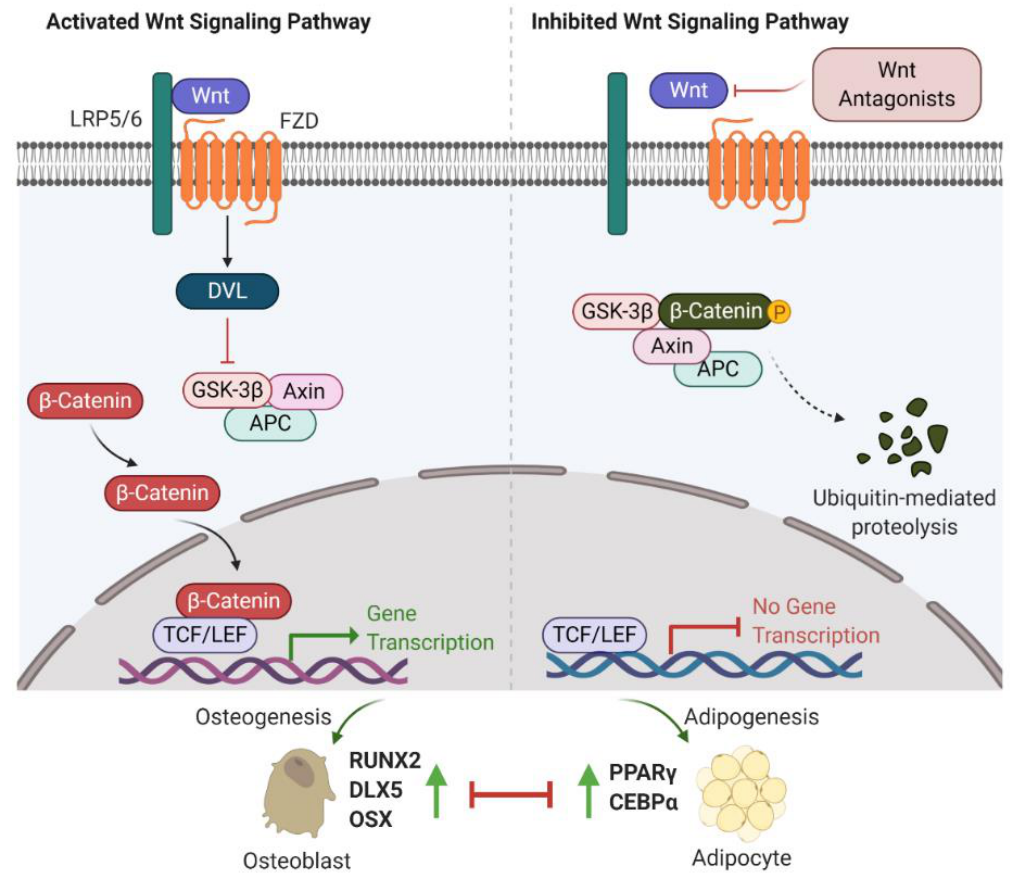
Figure 1. Wnt/ β -catenin signalling involved in bone or fat regulation. ( Left ) In case Wnt ligand is binding to co-receptor complex, β -catenin is released from the destruction complex composed of GSK-3 β , Axin and APC. This allows β -catenin to be accumulated and translocated into nucleus. By interacting with TCF/LEF transcription factors, β -catenin activates the osteogenic-related gene transcription program and promotes osteogenesis and bone formation. ( Right ) In case Wnt ligand is not able to bind to its co-receptor complex (e.g., in the presence of Wnt antagonists (sFRP-1, WIF-1, DKKs and sclerostin)), β -catenin is sequestered by the degradation complex, phosphorylated and subsequently degraded. Attenuated β -catenin enhances adipogenesis and marrow fat formation. Wnt: Wingless; LRP5/6: low-density lipoprotein receptor-related protein 5/6; Frizzled: FZD; DVL: disheveled; GSK-3 β : glycogen synthase kinase 3 β ; APC: adenomatous polyposis coli; TCF/LEF: T-cell factor/lymphoid enhancer-binding factor; RUNX2: runt-related transcription factor 2; DLX5: distal-less homeobox 5; OSX: osterix; PPAR γ : peroxisome proliferator-activated receptor γ ; C/EBP α : CCAAT/enhancer-binding protein α